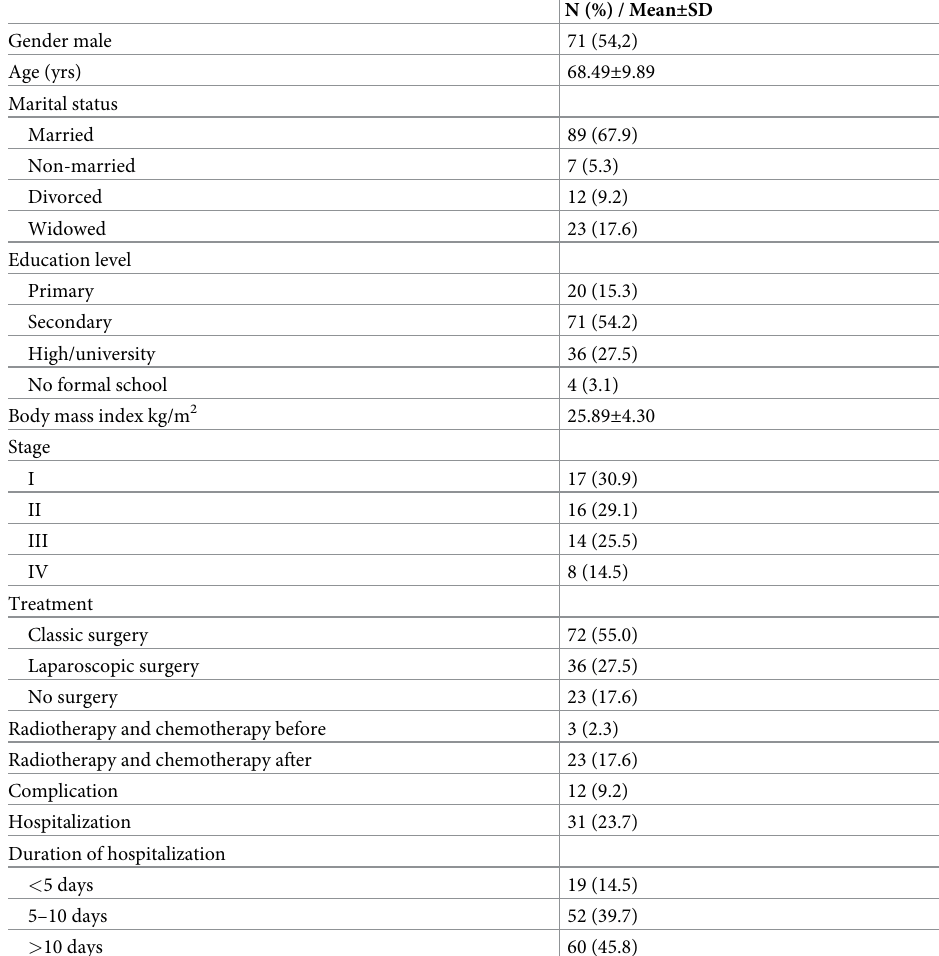
Table 1. Socio-demographic characteristics of study subjects.